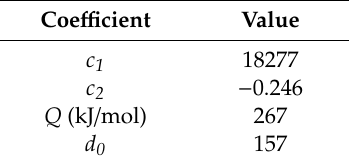
Table 6. Coefficient for grain evolution during MDRX [27]. Table 6. Coe ffi cient for grain evolution during MDRX [27].